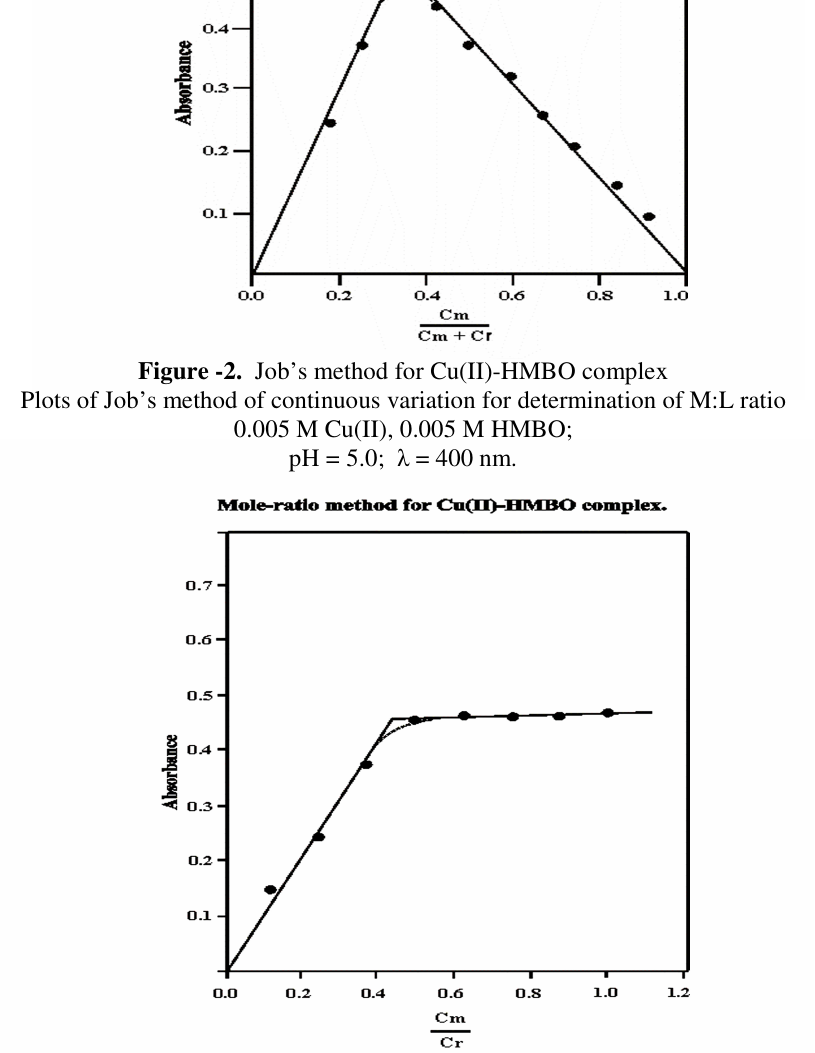
Figure -3. Mole-ratio method for Cu(II)-HMBO complex Plots of Yoe and Jone’s method for determination of M:L ratio 0.005 M Cu(II), 0.005 M HMBO; pH = 5.0; (cid:3) = 400